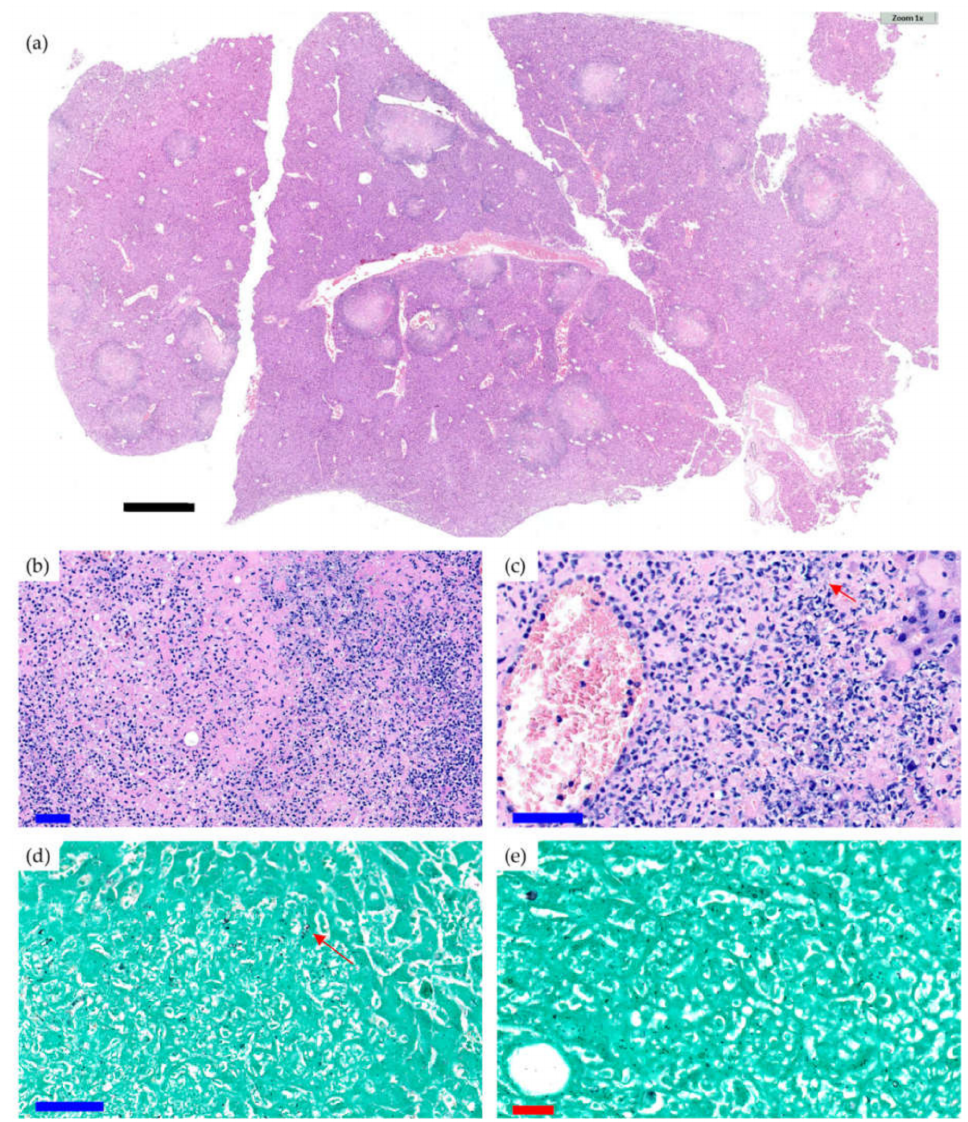
Figure 3. Histological section of the liver of a mouse of the CP Cal35 group that died of CMV infec- tion ( a ) and histological sections with a greater increase in H&E ( b , c ) and Groccot’s silver stain ( d , e ). Black, blue, and red bars represent 2 mm, 50 µ m, and 20 µ m, respectively. The liver of the animal showed parenchyma with foci of necrosis and a polymorphonuclear-type inflammatory infiltration accompanied by occasional Grocott-positive intracellular inclusions inside some hepatocytes, which was compatible with a cytomegalovirus infection. An acute necrotising inflammatory reaction was detected around the central